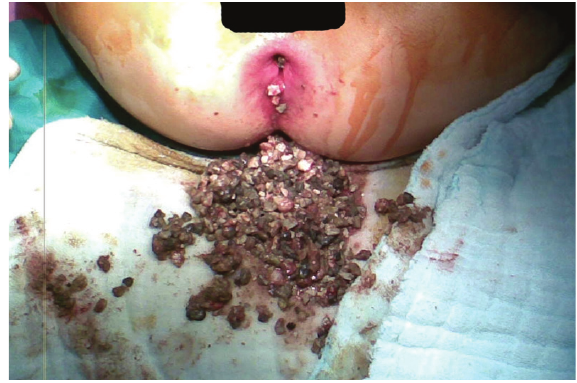
F 2: Anal dilatation and extraction of